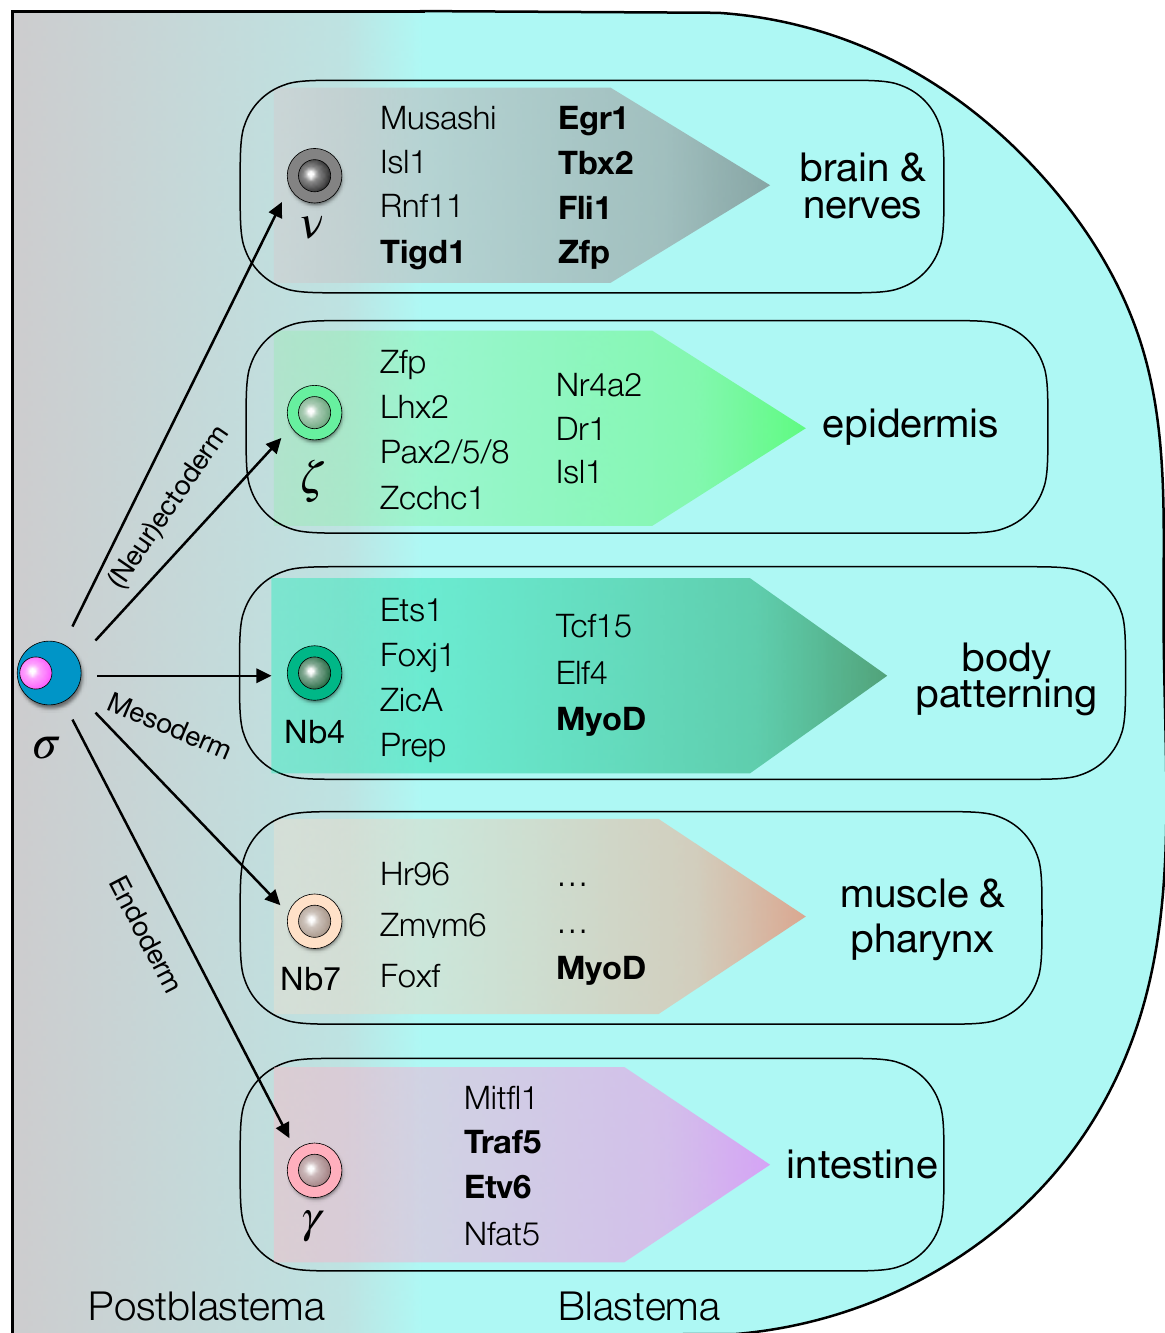
Figure 9. The blastema transcriptional regulatory genes landscape. The transcription factors expressed by the cells within the blastema could be either restricted to a specific lineage/tissue or not, as emerged from WISH and RNAi data. (functionally-validated genes are shown in bold).